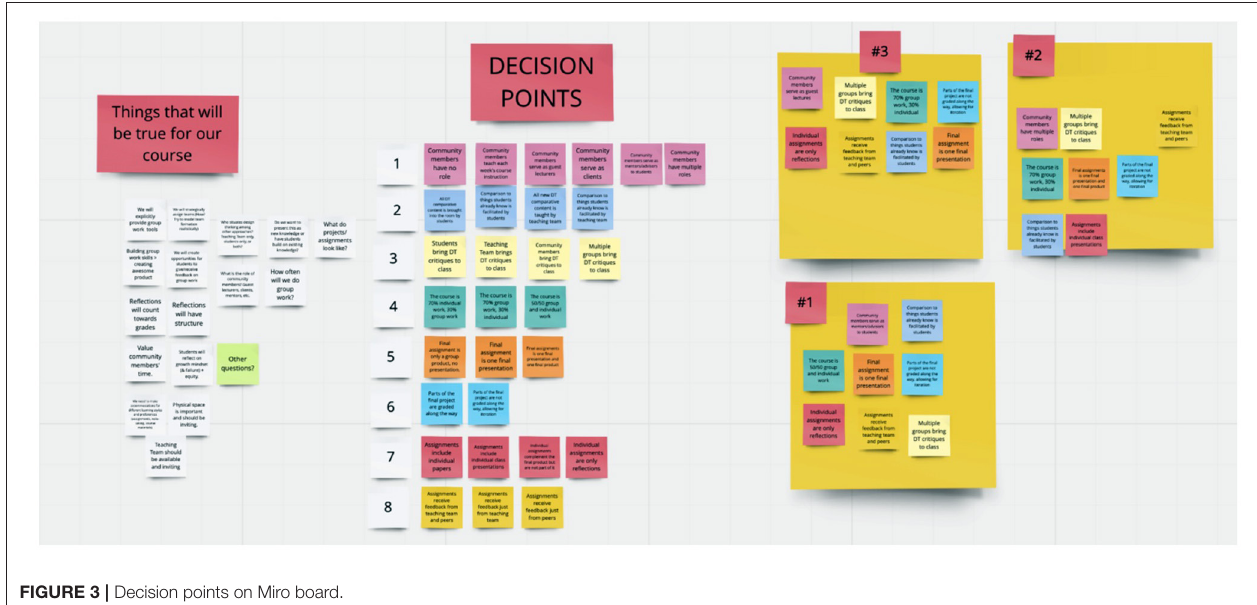
FIGURE 3 | Decision points on Miro board.